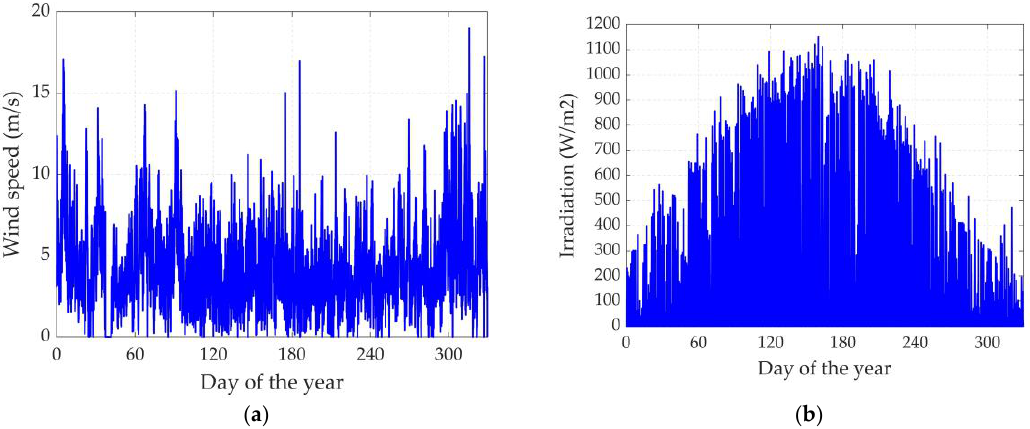
Figure 8. Annual change profile: ( a ) wind speed at the height of 10 m above the ground level, ( b ) irradiance in the analyzed geographical location.